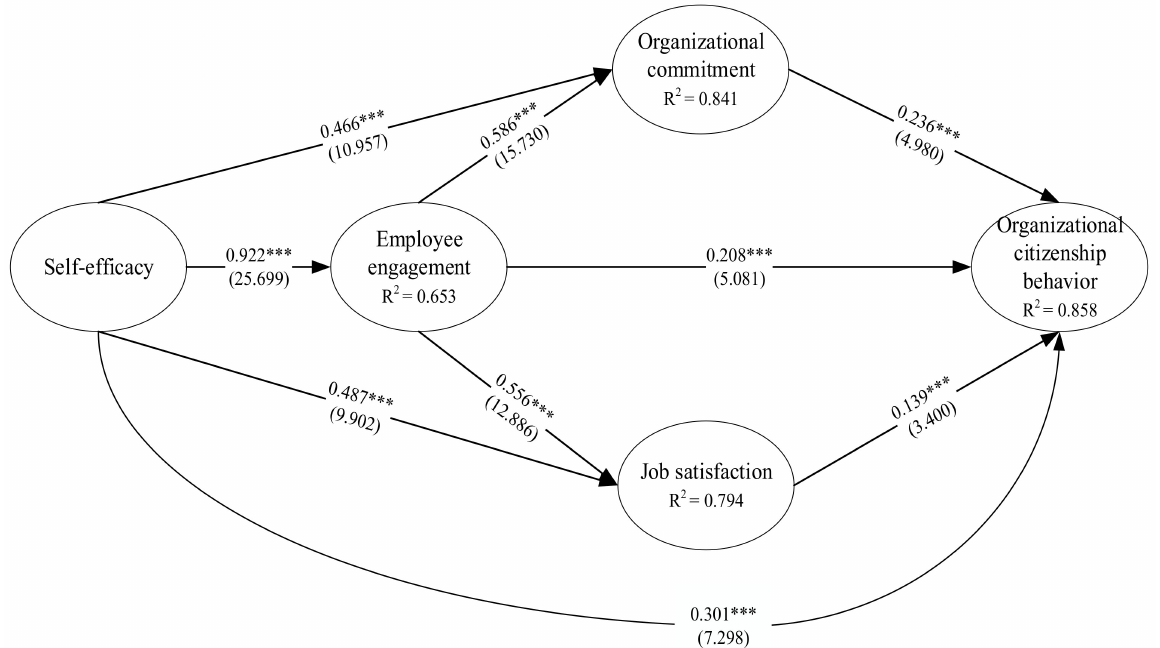
Figure 3. Analysis of the direct and indirect influence of self-efficacy on organizational citizenship behavior in relation to employee engagement, organizational commitment and job satisfaction as mediators. Note: *** refers to the significance level at 0.001.